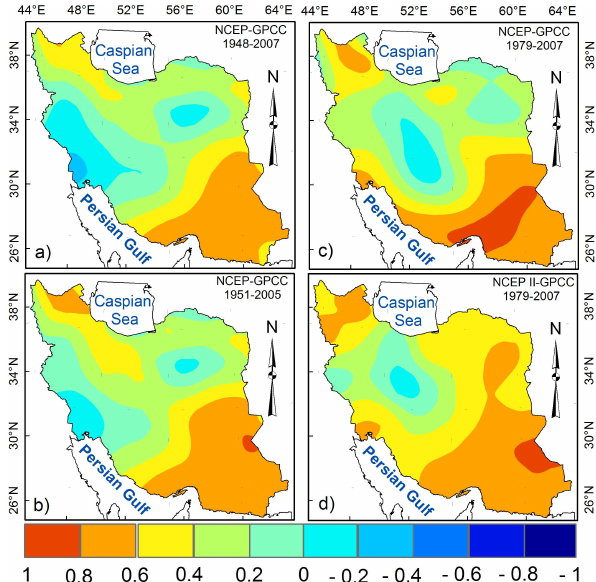
Fig. 8. SPI (on 24-month time scale) correlation maps for different time sections and datasets: a) NCEP/NCAR and GPCC for the pe- riod 1948–2007, b) NCEP/NCAR and GPCC for the period 1951– 2005, c) NCEP/NCAR and GPCC for the period 1979–2007, and d) NCEP Reanalysis II and GPCC for the period